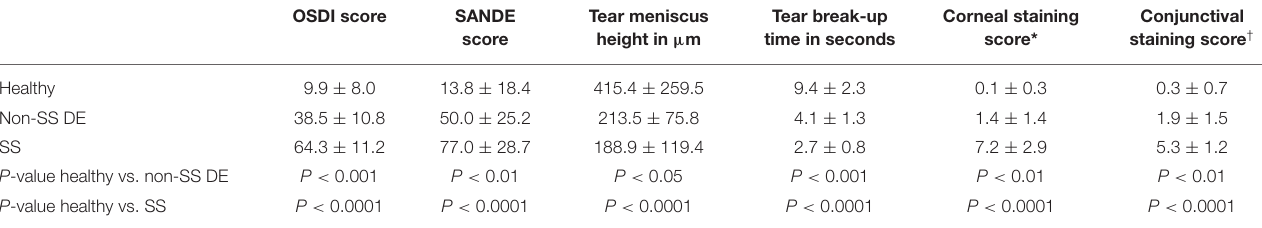
TABLE 2 | Summary of clinical